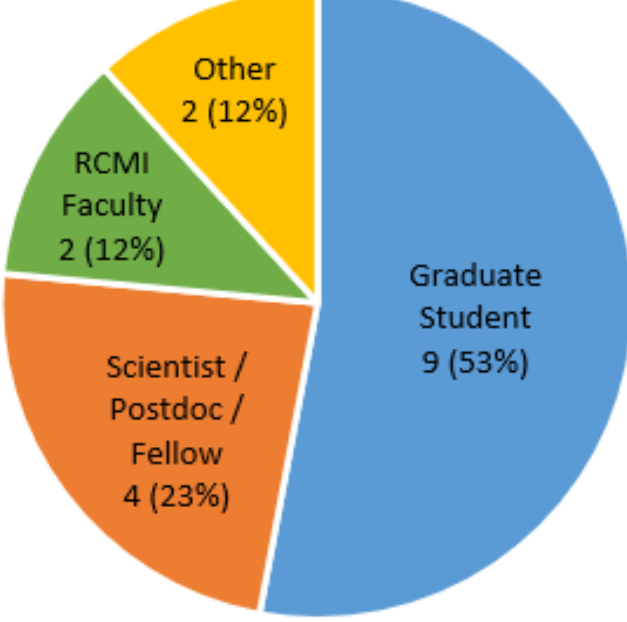
Figure 3. Diversity of applicants for our data science